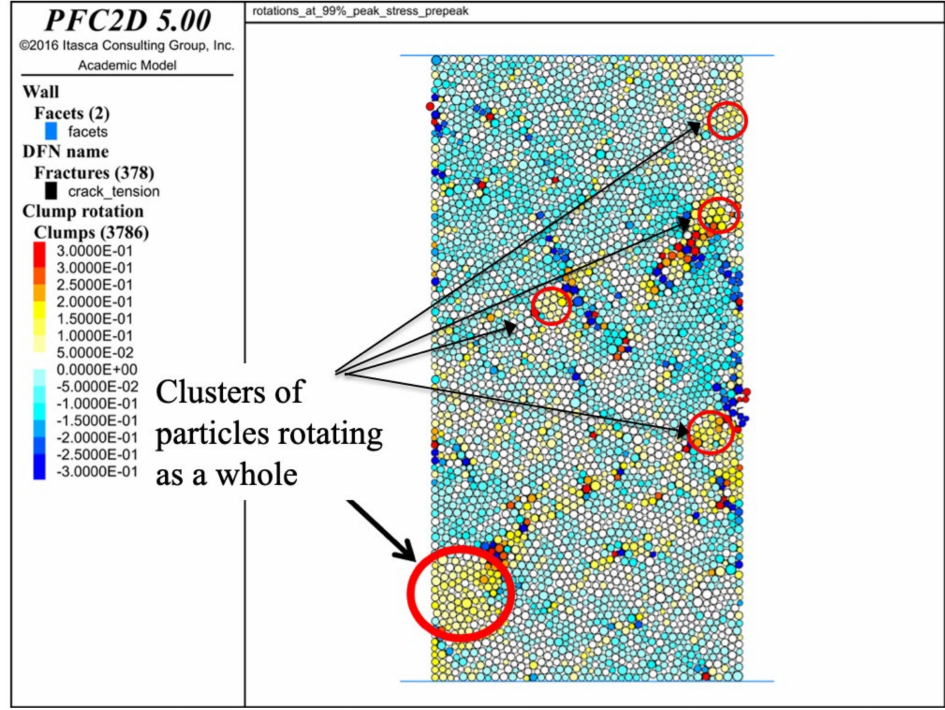
Figure 2. Clusters of particles rotating in the same direction (rotations are counted with respect to the initial positions of the particles). The colour scheme is shown on the left side of the picture; the angles are in